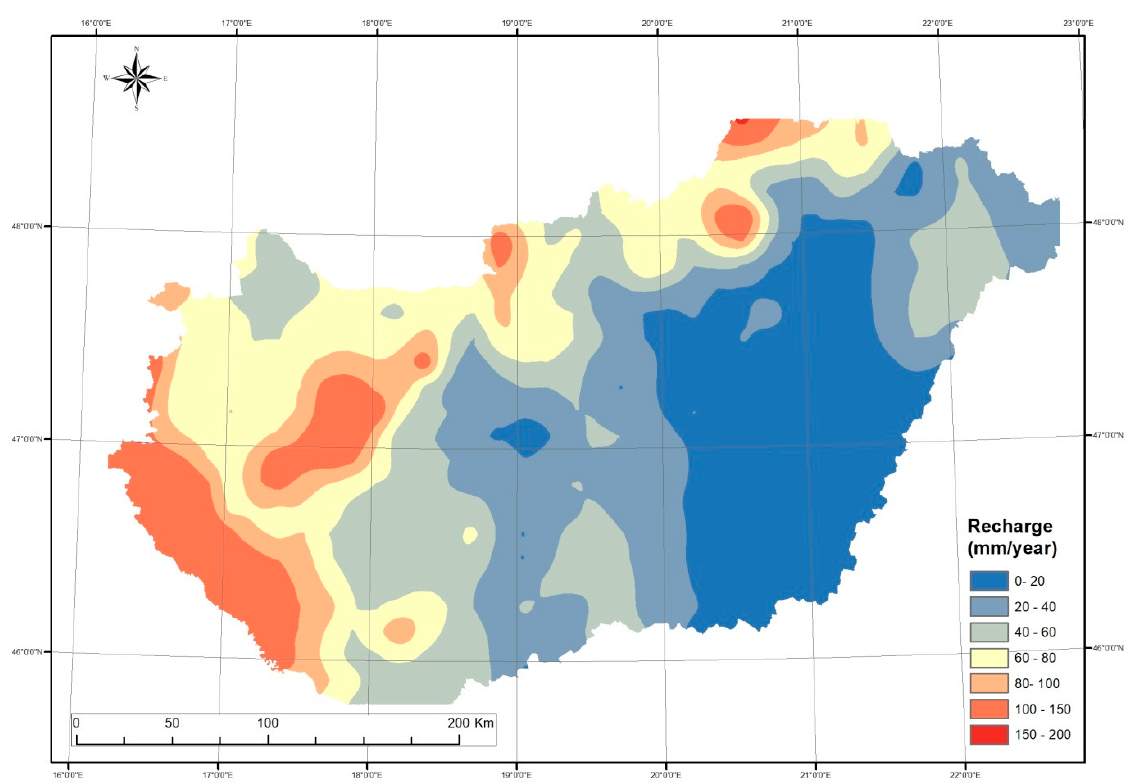
Figure 8. Distribution of simulated recharge averaged between 1961 and 1965, based on CARPATCLIM dataset.